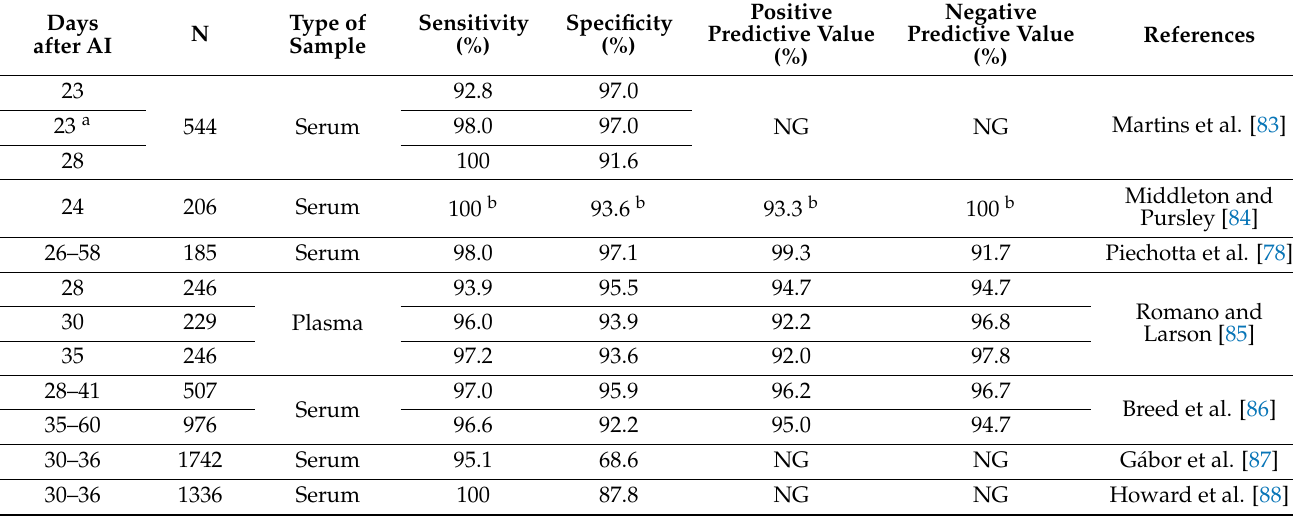
Table 5. Accuracy of commercially available ByoPRYN pregnancy ELISA tests for diagnosing early pregnancy in dairy cattle.